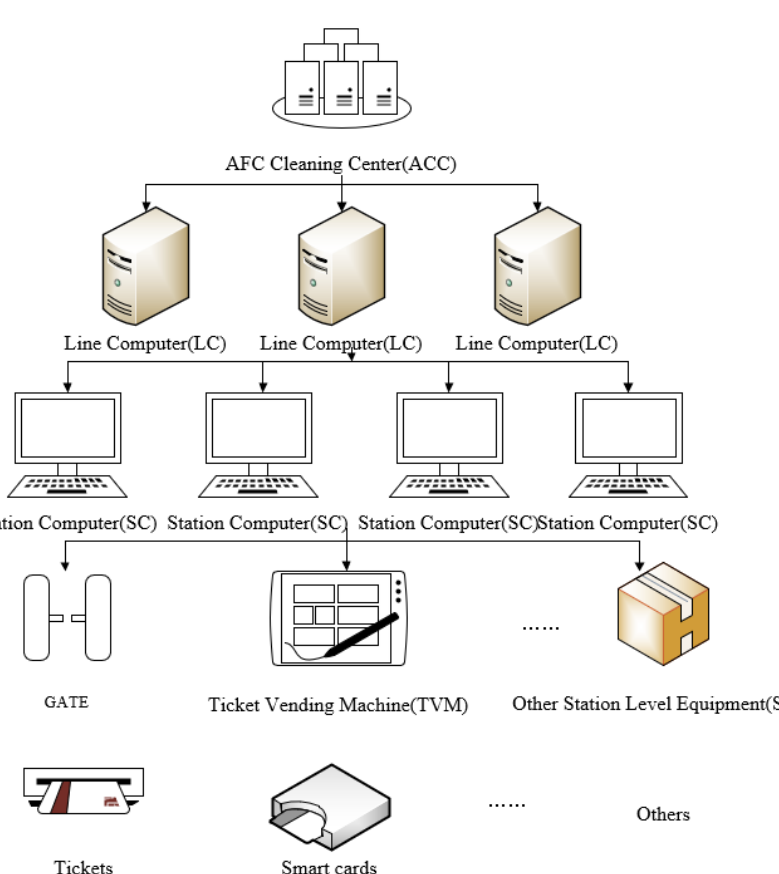
Figure 1. Five hierarchical levels of automatic fare collection (AFC) system.